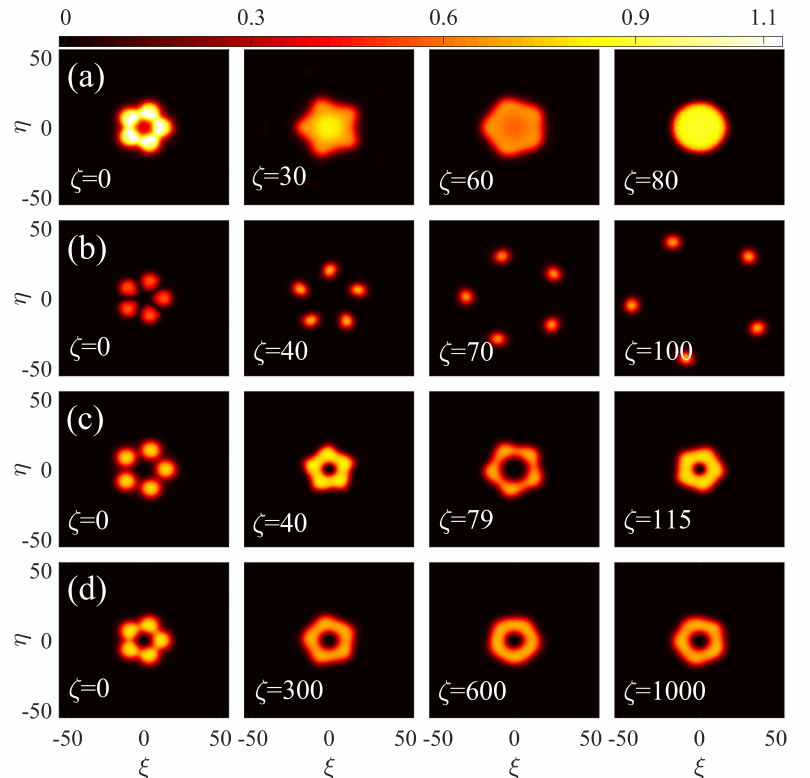
Figure 14. The evolution of necklace-shaped clusters initially built, as per Equations (44) and (45), of M = 5 fundamental solitons and carrying overall vorticity S = 0 ( a ), S = 2 ( b ), and S = 1 ( c , d ). The initial radii of the inputs and the angular velocity of their rotation, produced by the evolution are, respectively, ( R , ω ) = ( 11.25,0 ) ( a ); ( 10.35,0.0128 ) ( b ); ( 13,0.005 ) ( c ); and ( 10.35,0.0071 ) ( d ). The re- sults were produced by simulations of Equation (36) with Lévy index α = 1. In this figure, coordinates x , y and z are denoted, respectively, as ξ , η and ζ . The figure is borrowed from Reference